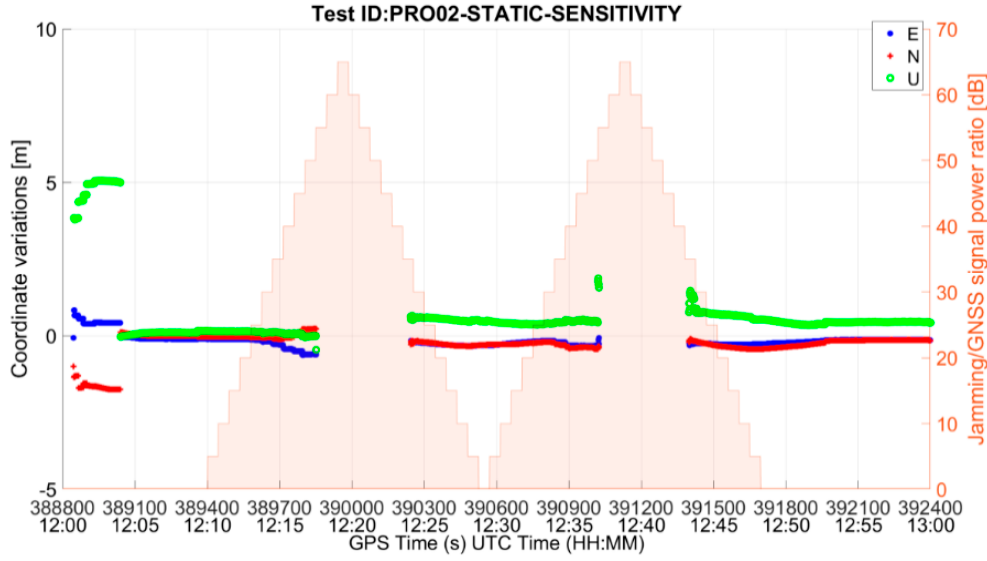
Figure 7. East-North-Up deviations for PRO RUT in the presence of threat signature 02.